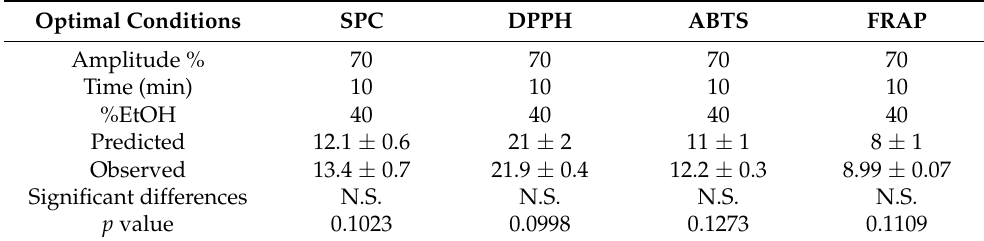
Table 4. Optimal conditions for UAE sonotrode